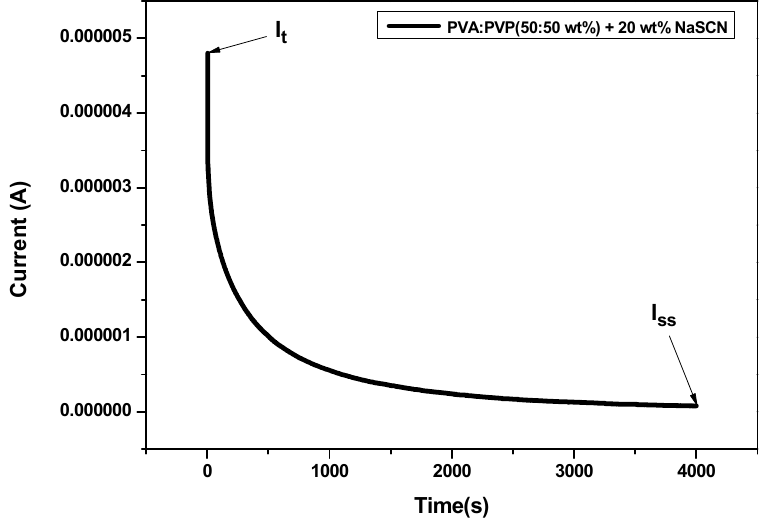
Figure 10. Polarization current vs. Time for the high conductive PE film at applied voltage 80 mV at room temperature.